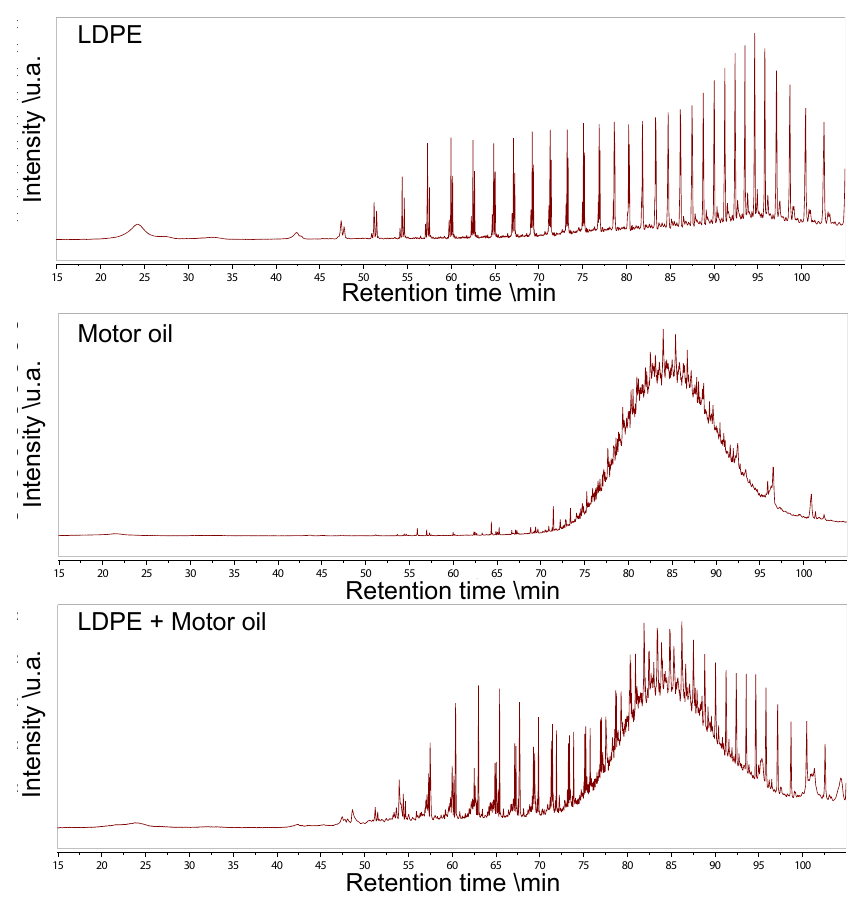
Figure 5. Resulting chromatograms of the Pyrolysis coupled to gaseous chromatograph and mass spectrometry (Py-GC/MS) experiments performed on LDPE, motor oil, and a mixture of motor oil and LDPE (70 wt% of